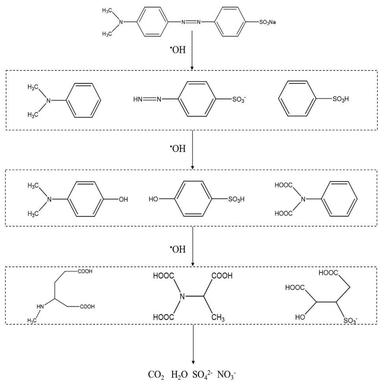
Possible degradation pathways of MO in this EAOPs.